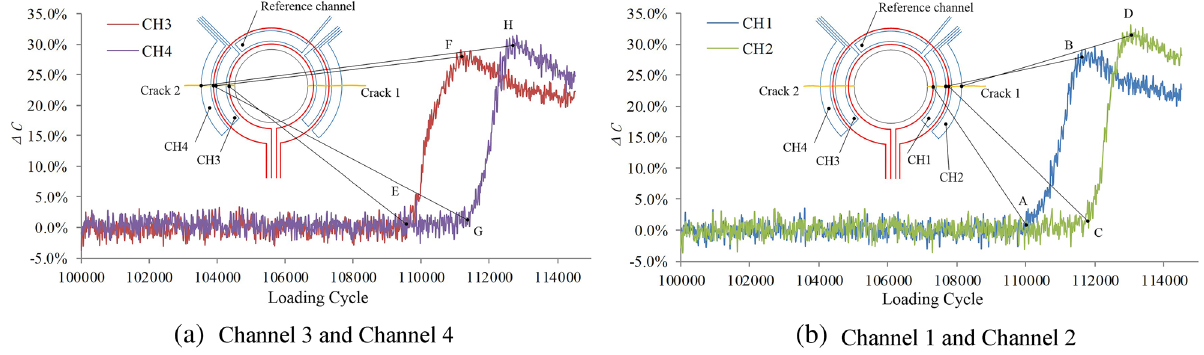
Figure 16. Relationship between sensor output signal and the number of loading